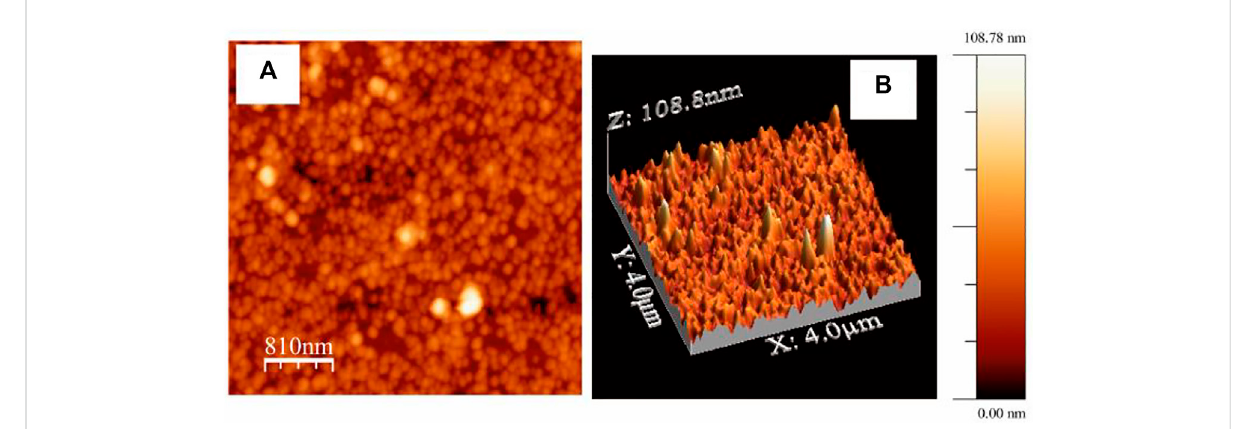
FIGURE 7 (A) 2D and (B) corresponding 3D AFM images of LB fi lm of the APS.